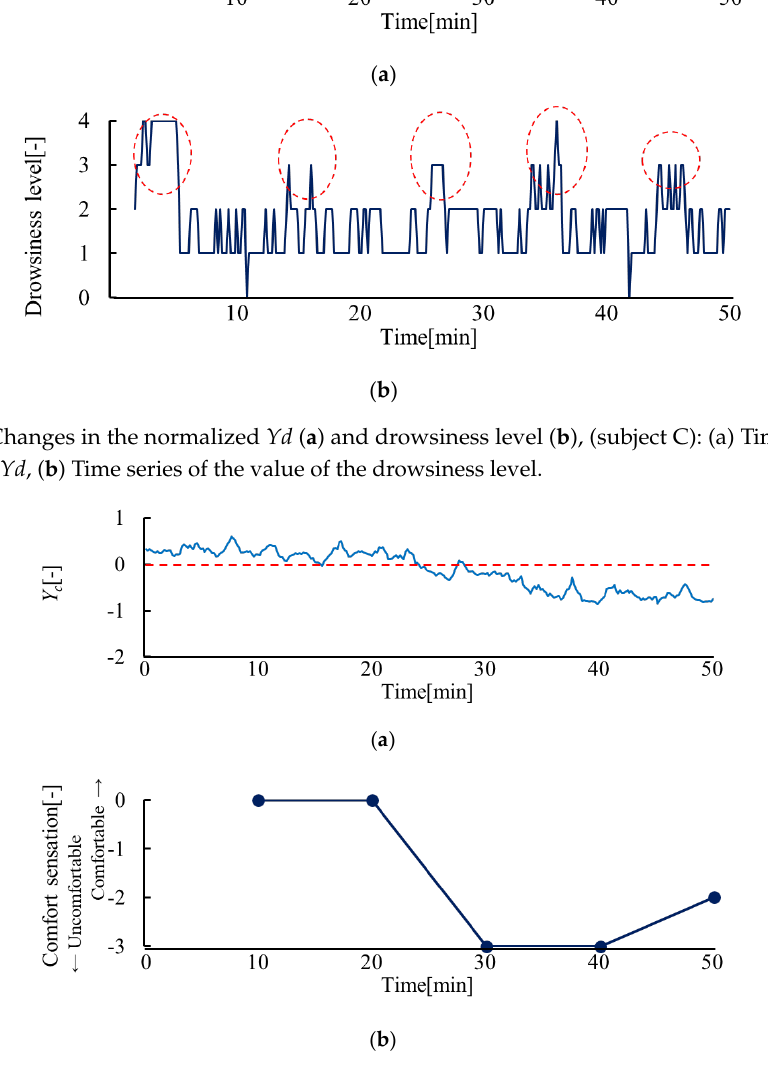
Figure 11. Changes in Yc ( a ) and the value of the comfort sensation vote ( b ): Time series of the value of the comfort sensation vote, (subject